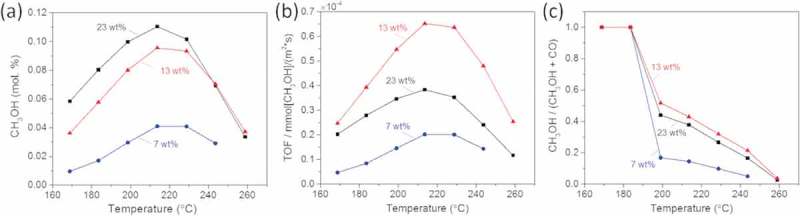
(a) Methanol yield, (b) Turnover frequency (TOF) and (c) CH3OH-to-CO ratio measured from the GaPd2/SiO2 catalyst with the three metal loadings, as a function of reaction temperature.